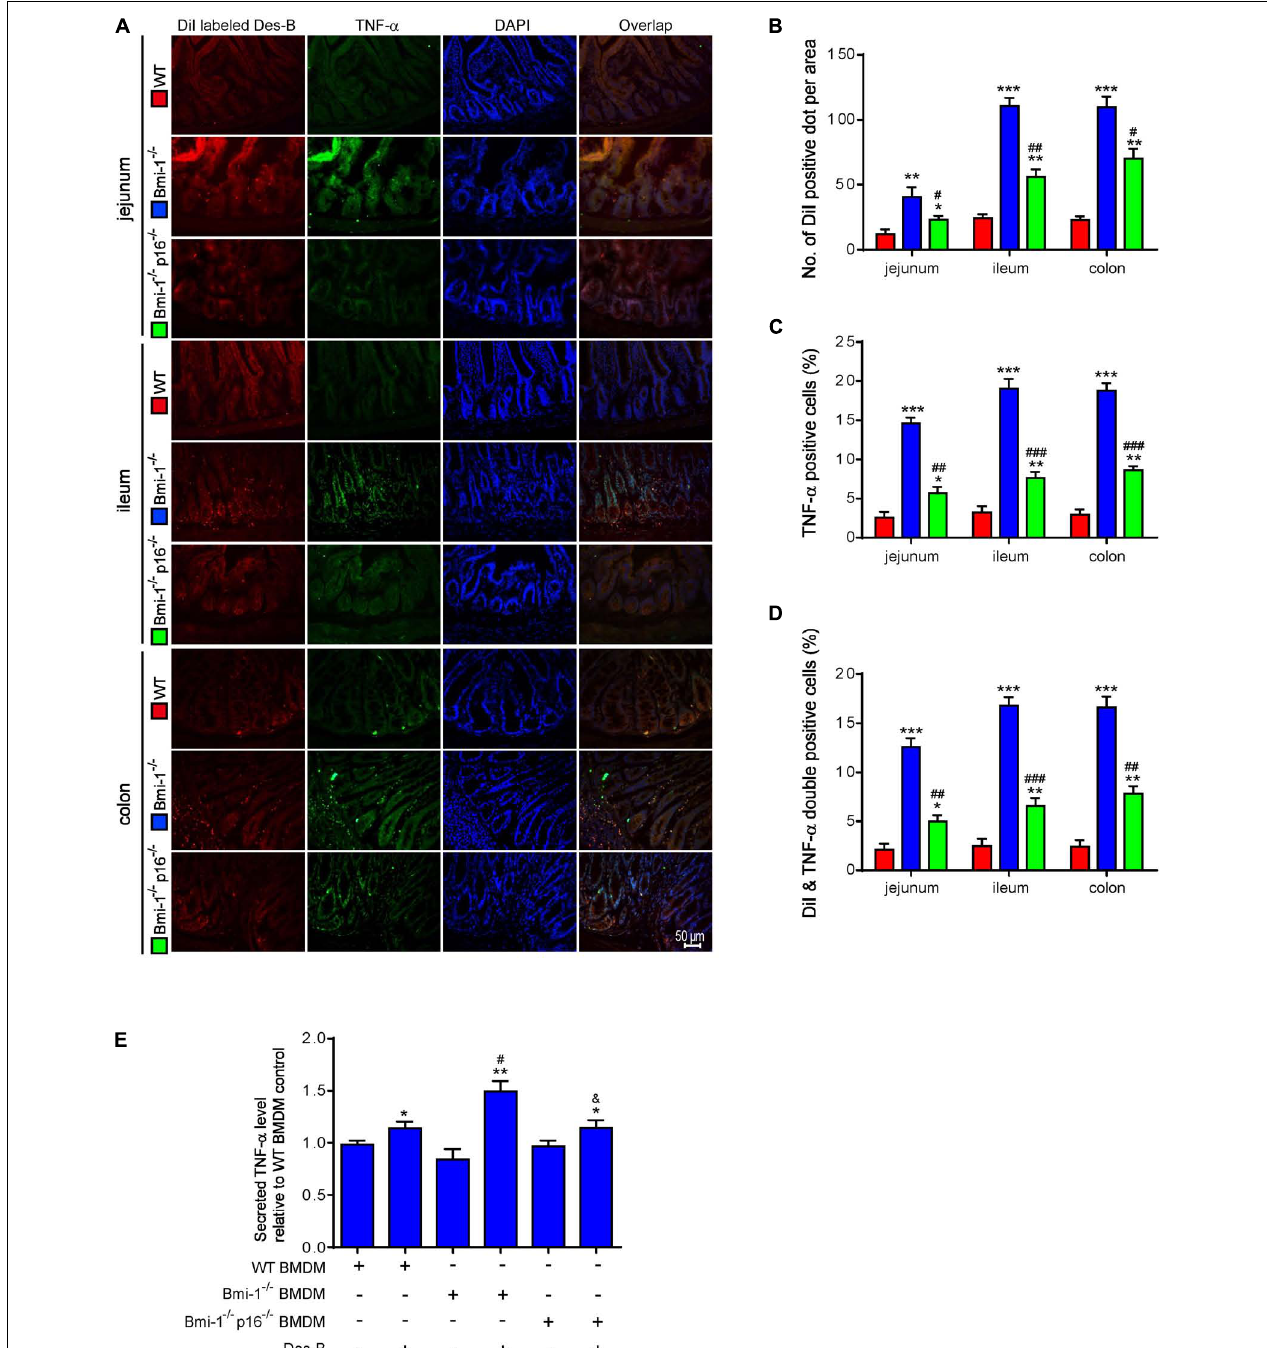
FIGURE 9 | P16 deletion ameliorated the increase in macrophages-secreted TNF- α resulting from Bmi-1 deficiency. DiI-labeled Desulfovibrio (Des-B) was administered by oral gavage into 7-week-old Bmi-1 − / − , Bmi-1 − / − p16 − / − , and WT mice. (A) Representative micrographs showing immunofluorescence for TNF- α in jejunum, ileum, and colon, with DAPI staining the nuclei. (B) Number of DiI-positive dot per area. (C) TNF- α –positive cells. (D) Dil-labeled Des-B and TNF- α double-positive cells. Six mice per group were used for experiments. Values are mean ± SEM from six determinations per group, * p < 0.05, ** p < 0.01, *** p < 0.001 compared with the WT group; # p < 0.05, ## p < 0.01, ### p < 0.001 compared with the Bmi-1 − / − group. BMDMs was isolated and cultured from bone marrow of WT, Bmi-1 − / − , and Bmi-1 − / − p16 − / − mice. (E) Secreted TNF- α level was detected in the supernatant of BMDMs treated with Des-B or vehicle using ELISA. Cell experiments were performed with three biological repetitions per group. Statistical analysis was performed with one-way ANOVA test. Values are mean ± SEM from six determinations per group, * p < 0.05, ** p < 0.01 compared with the Des-B vehicle group; # p < 0.05, ## p < 0.01, ### p < 0.001 compared with the same treatment of WT-BMDM group; & p < 0.05 compared with the same treatment of Bmi-1 − / − –BMDMs.